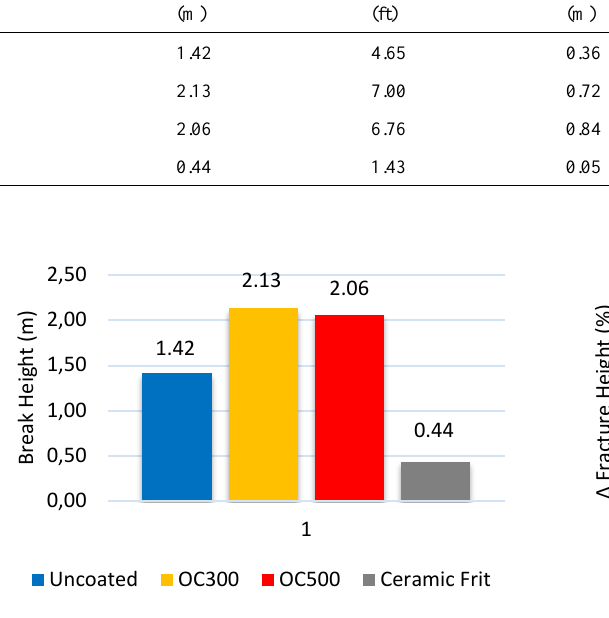
Figure 8. Mean fracture height of coated and uncoated specimens. Figure 9. Percent change in fracture height of coated specimens